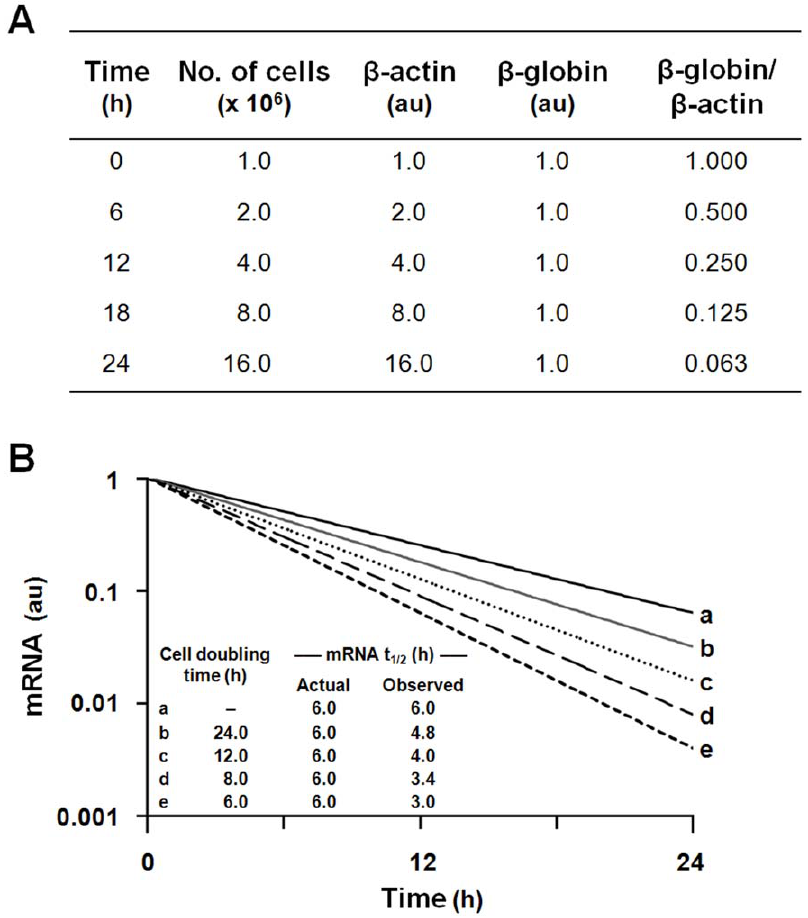
Figure 1. Effects of cell doubling time on the apparent t 1/2 value of a study mRNA. (A) Hypothetical mRNA decay. Cell aliquots, each originally containing 1.0 6 10 6 cells, are incubated for defined intervals between 0 and 24 hours. Cells in each aliquot double every 6 hours, in parallel with the total amount of b -actin mRNA. At T=0, each aliquot contains an equal quantity [1 arbitrary unit (au)] of an infinitely stable b -globin mRNA, encoded by a gene that has been transcriptionally silenced. The decline in the ratio of the globin:actin mRNAs, which erroneously indicates a half-life value of 6 hours for the globin mRNA, fails to account for interval expansion in cell number. These same principles apply to mRNAs with finite stabilities (panel B). (B) True and uncorrected t 1/2 values in cells with different doubling times. Curves illustrate the uncorrected half-life for a test mRNA, following transcriptional silencing of its encoding gene, if the interval expansion in cell number is not considered. The examples utilize an mRNA with a true t 1/2 =6 h, expressed in cells that are growth arrested (curve a ) or display doubling times of 24, 8, 6, or 4 hours (curves b through e , respectively).